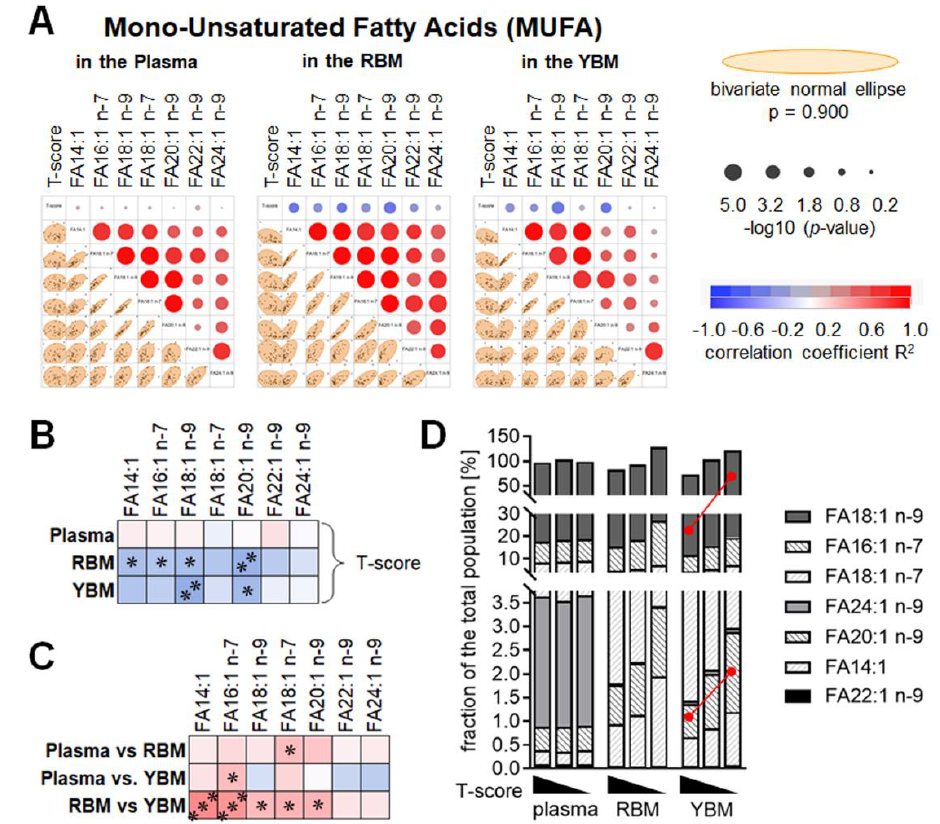
Figure 3: The composition of mono-unsaturated fatty acids (MUFA) is altered depending on the age- adjusted bone mineral density (T-score), especially in the yellow bone marrow (YBM). ( A ) Multivariate analysis of the measured MUFA in the plasma, red bone marrow (RBM), and YBM. Correlations are presented as bivariate fitted normal ellipses ( p = 0.90) with individual data points and summarized as colored significance circles. ( B ) Summary of the correlations of the T-score and the individual MUFA in the plasma, RBM, and YBM. ( C ) Summary of the correlations of the individual MUFA measured in plasma, RBM, and YBM. Colors represent the correlation (red: positive / blue: negative) with * p < 0.05, ** p < 0.01, and *** p < 0.001. ( D ) The composition of the individual MUFA based on the T-score in the plasma, RBM, and YBM is summarized as stacked bars. The amount of MUFA is presented as % of the average amount of all 30 samples investigated. The red lines mark significant ( p < 0.05) changes be- tween the three groups (normal bone mineral density / osteopenia /